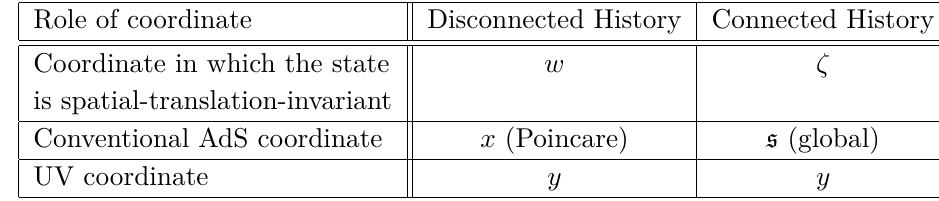
Figure 9. The conformal transformation from the U(1) symmetric ζ cylinder to the s cylinder in which the quench happens. There are two slits in the s cylinder because we need to use this manifold for expectation values, and so need both a ‘ket’ as well as a ‘bra’ copy of the state. This figure is in Euclidean space whereas figure 6 in the previous subsection is in Lorentzian space.